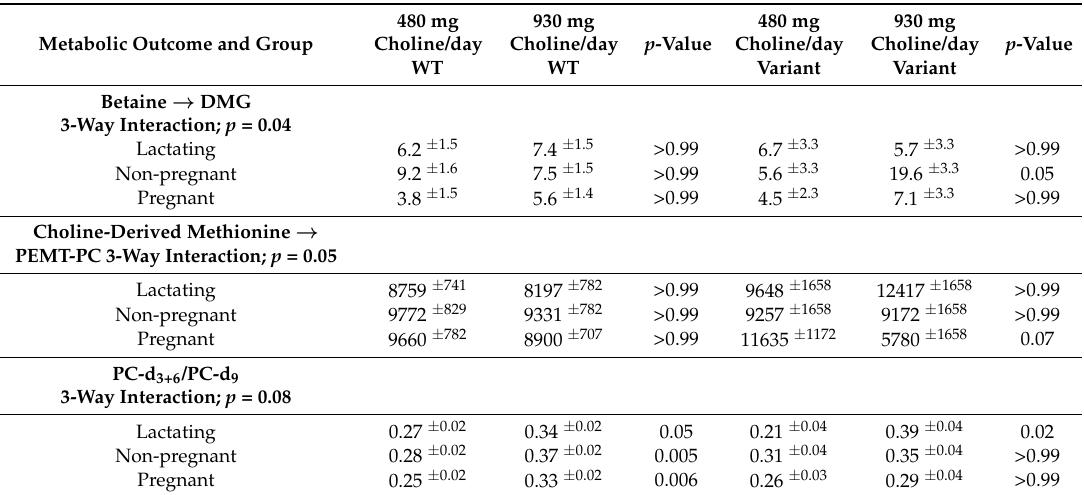
Table 16. SLC44A1 rs7873987 genotype alters the metabolic flux and partitioning of dietary choline. Values are least-squared means ± standard errors. Betaine → DMG values are in µ M DMG/study period. p -values represent the highest order interaction and pairwise comparisons between genotypes within intake